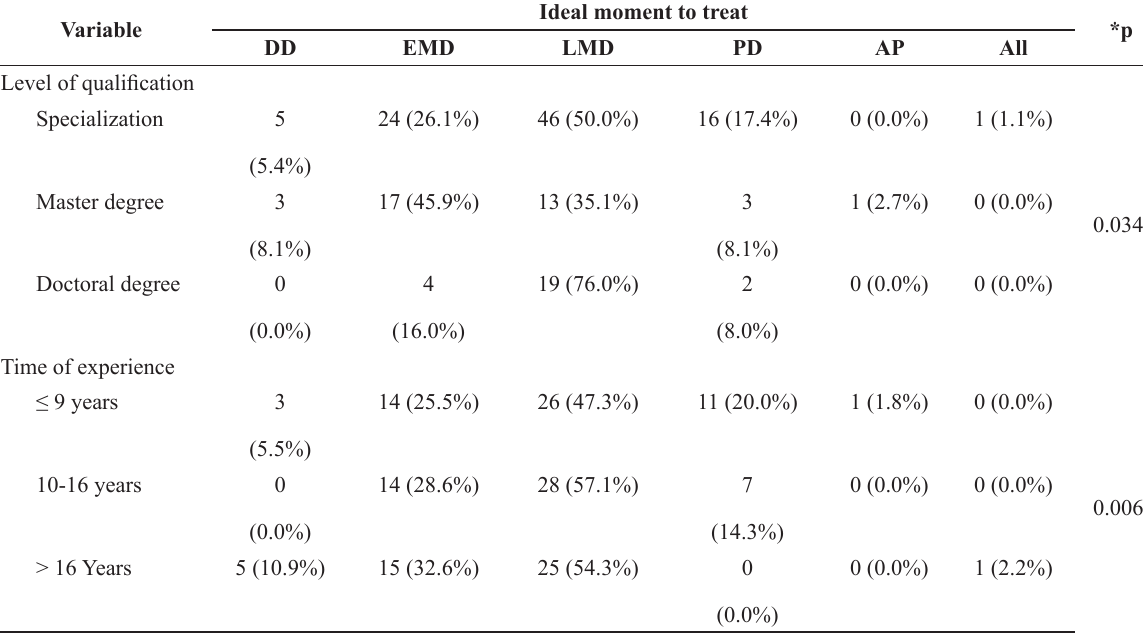
Association of the ideal moment to treat Class II malocclusions with the level of professional qualification and with the time of professional